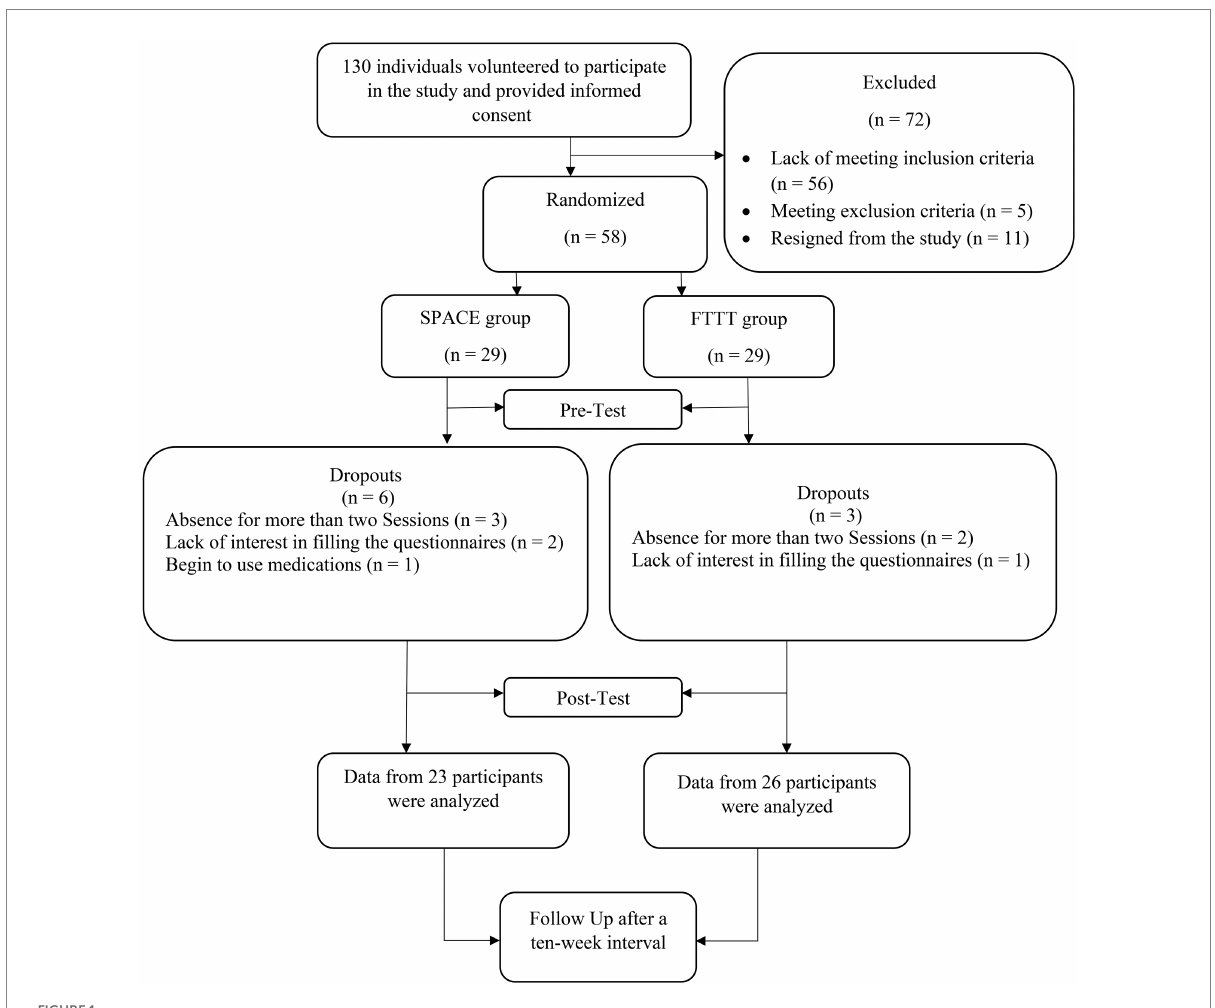
FIGURE 1 Process chart from recruitment to follow-up